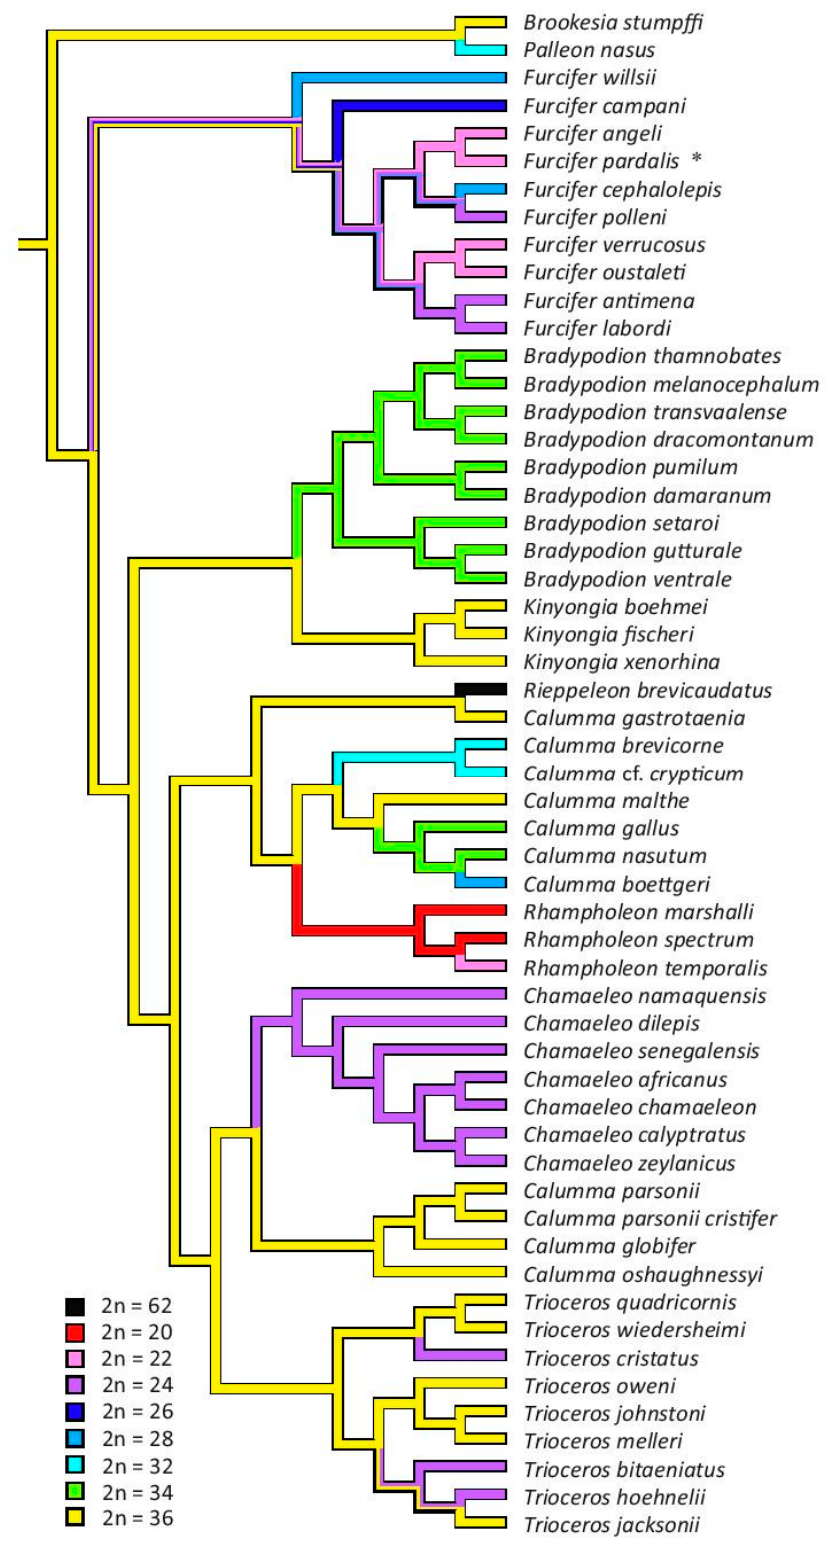
Figure 5. Phylogenetic analysis based on the tree by [32] with depicted number of chromosomes. Results of maximum parsimony analysis reconstructing ancestral chromosome number are visualized by colours of the branches. Asterisk (*) symbolises different chromosome number in female of Furcifer pardalis due to presence of neo-sex chromosomes.